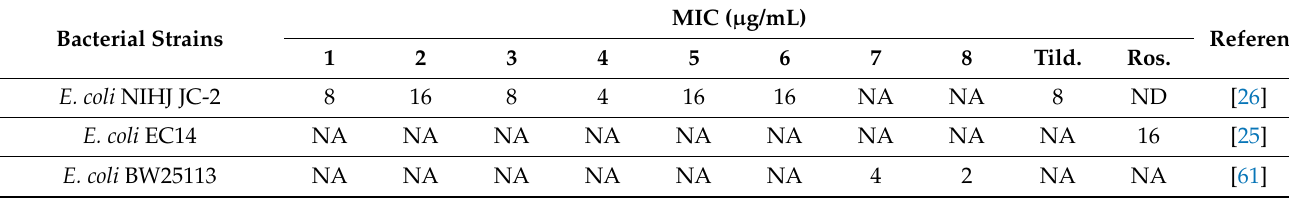
Table 7. MICs of selected